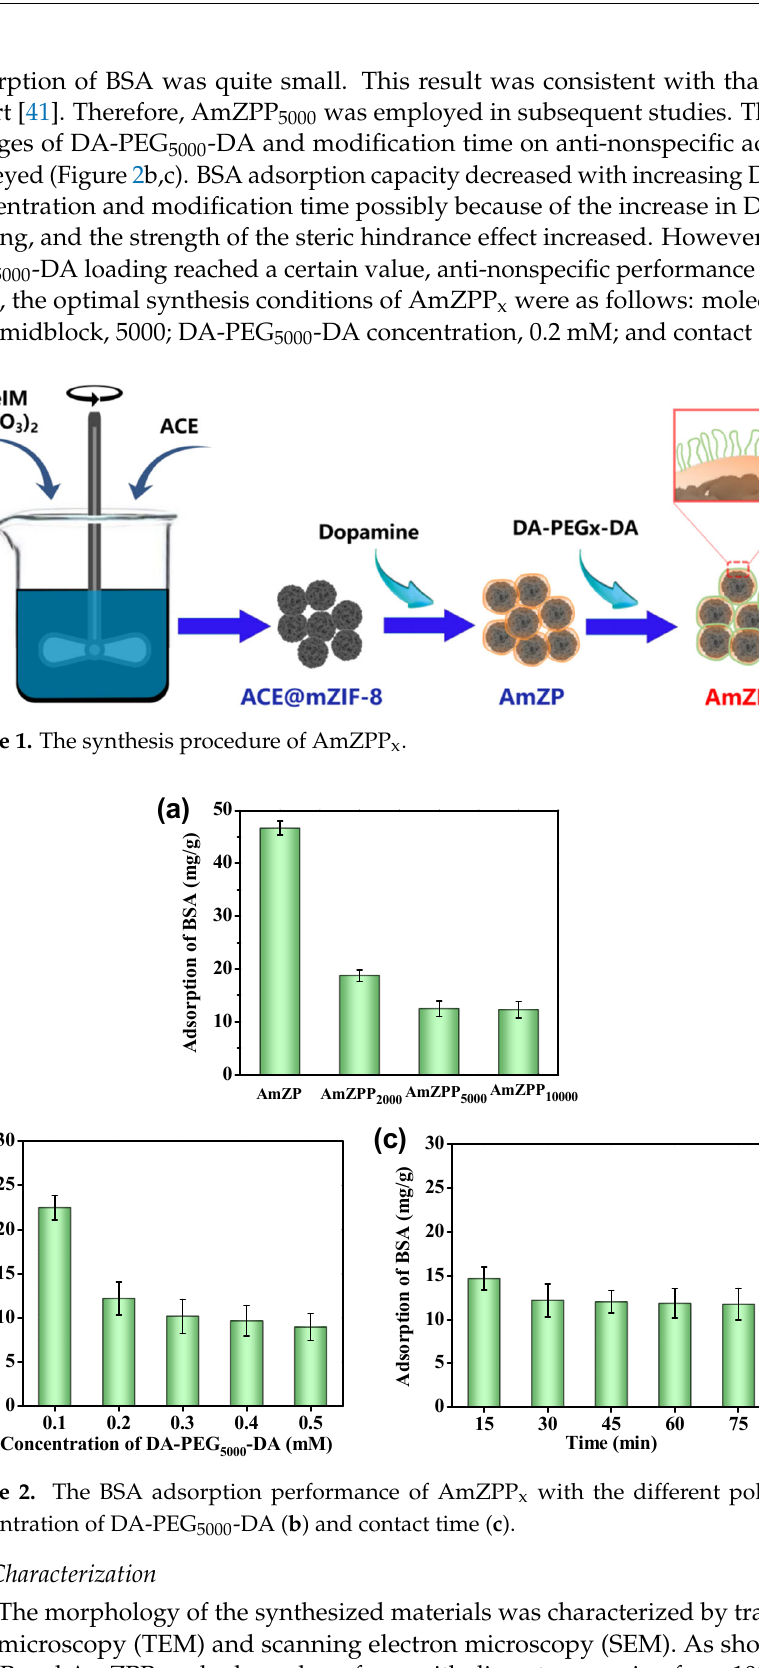
Figure 1. The synthesis procedure of AmZPP x .